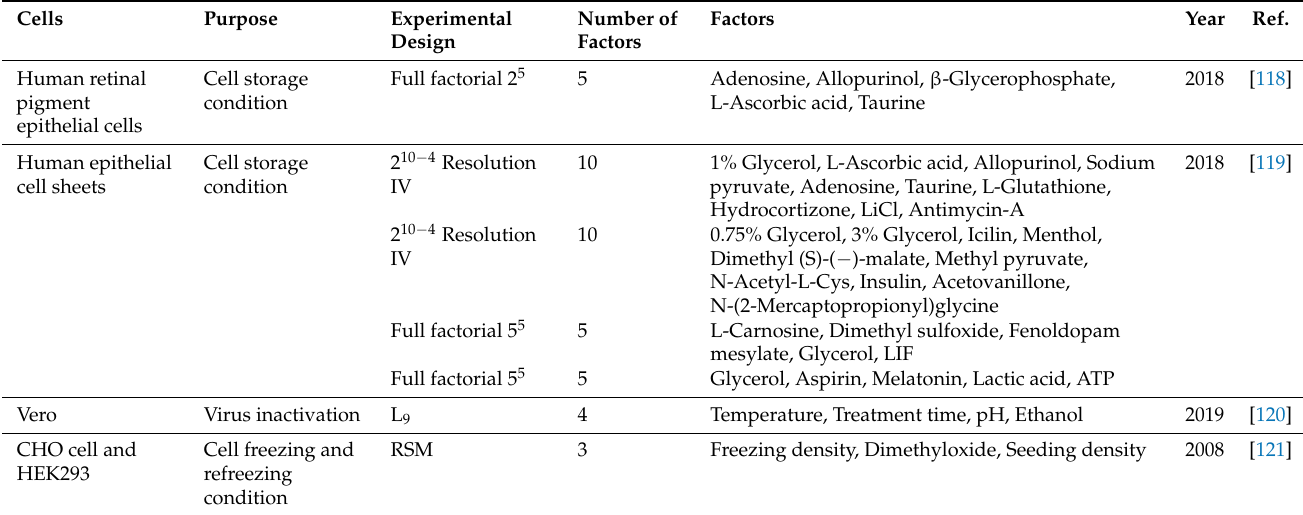
Table 8. DOE studies investigating other cell-related